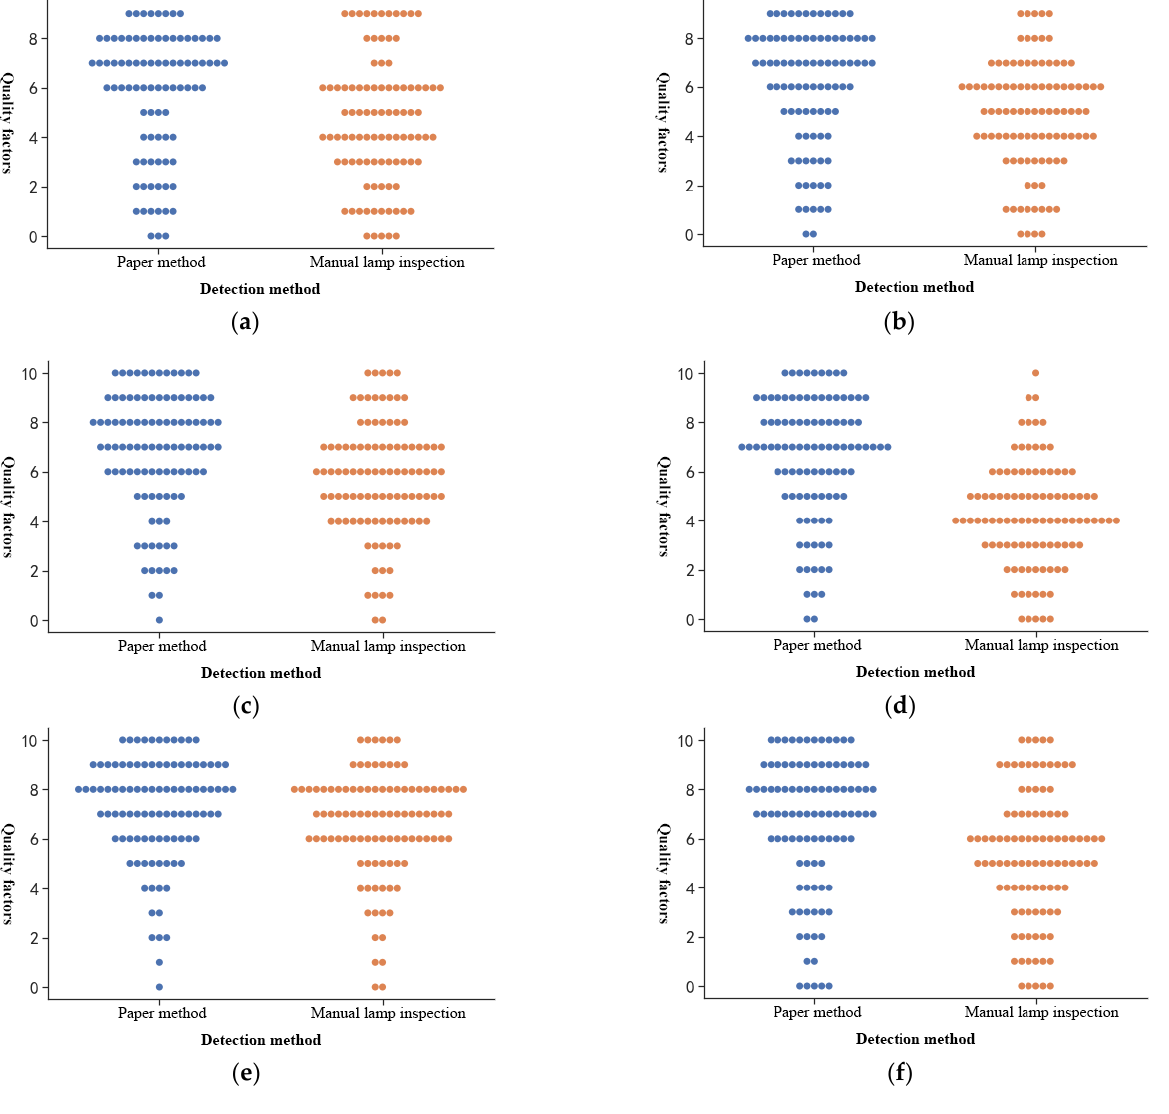
Figure 21. Statistical maps of the distribution of quality factors. ( a ) Experimental result of batch 1; ( b ) Experimental result of batch 2; ( c ) Experimental result of batch 3; ( d ) Experimental result of batch 4; ( e ) Experimental result of batch 5; ( f ) Experimental result of batch 6.